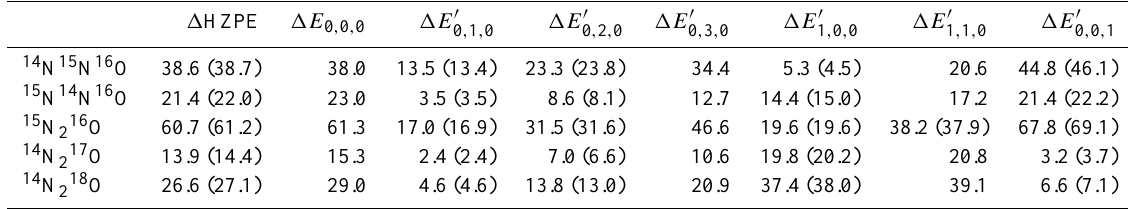
0 = E 0 ( 14 N 216 O ) − E 0 ( 14 N 218 O ) for 18 O and analogously for other i i i